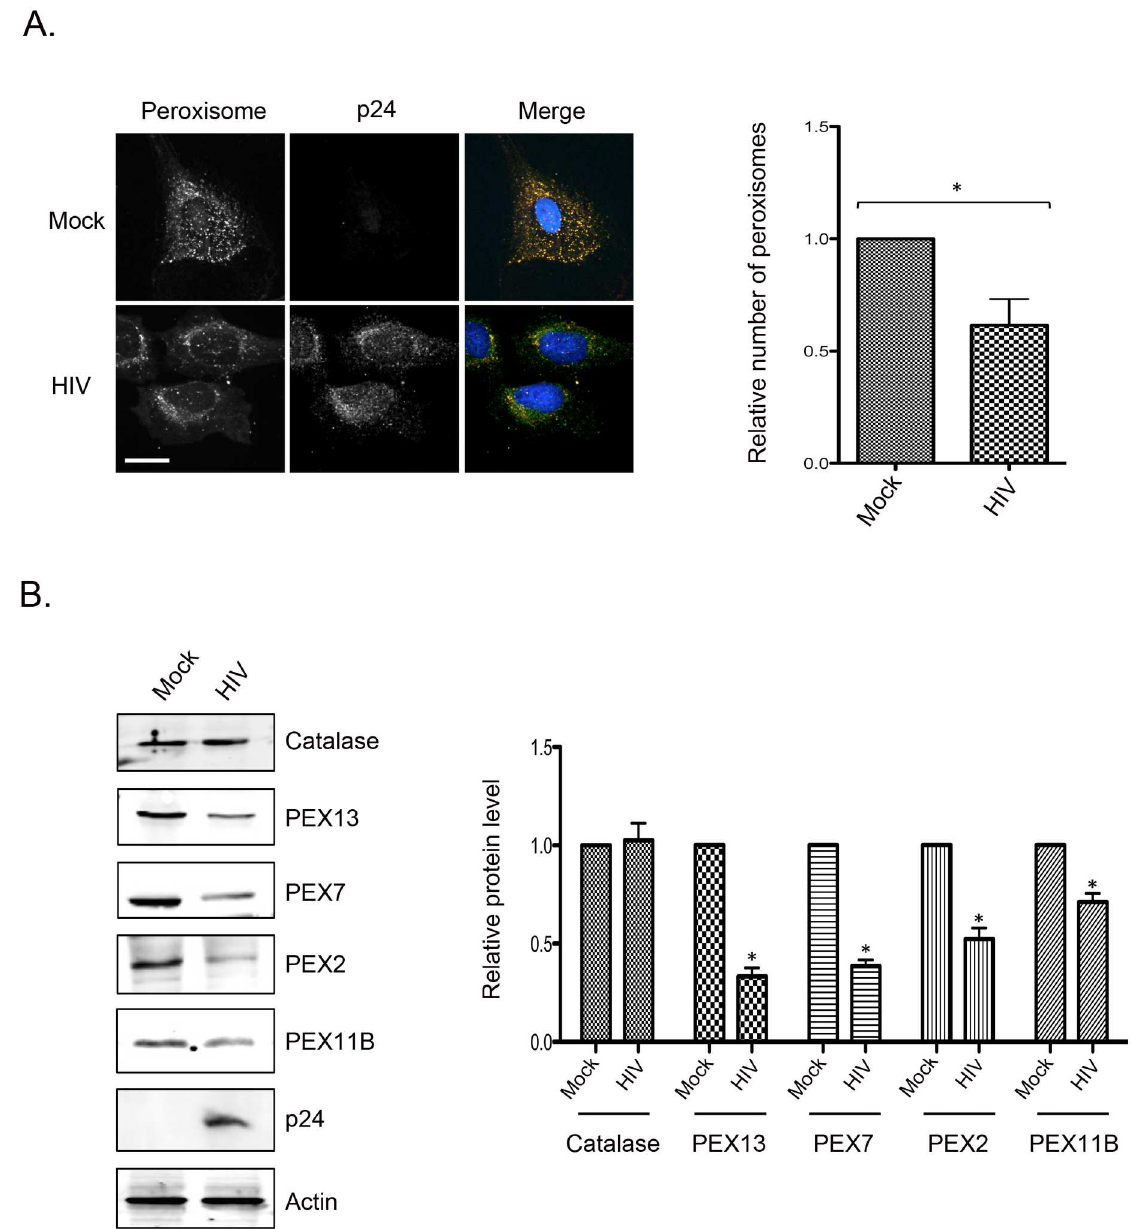
Fig 4. HIV-1 infection causes loss of peroxisomal proteins and reduces the abundance of peroxisomes. A. Hela CD4+ cells (clone 1022) were infected with HIV-1 (pYu2, MOI = 10.0) for 72 hours and then processed for indirect immunofluorescence and confocal microscopy. Peroxisomes were detected with a rabbit polyclonal antibody to peroxisomal targeting signal SKL and donkey anti-rabbit IgG conjugated to Alexa Fluor 546. HIV-infected cells were detected with a mouse monoclonal antibody to HIV-1 p24 protein and donkey anti-mouse IgG conjugated to Alexa Fluor 488. Nuclei were stained using DAPI. Images were obtained using spinning disc confocal microscopy. The numbers of peroxisomes (SKL-positive structures) in mock- and HIV-infected cells were determined using Volocity image analyses software. Averages were calculated from three independent experiments in which a minimum of 10 cells for each sample were analyzed. The average number in mock-treated cells was normalized to 1.0. Bars represent standard error of the mean. * p < 0.05. B. Primary monocyte-derived macrophages (MDM) were infected with HIV (pYu2, MOI = 2.0) for 5 days and then were subjected to immunoblot analyses with antibodies to Catalase, PEX2, PEX7, PEX11B, PEX13, HIV p24 and actin. The relative levels of peroxisomal proteins (compared to actin) from 3 independent experiments (3 donors) were averaged and plotted. Error bars represent standard error of the mean. * p < 0.05.